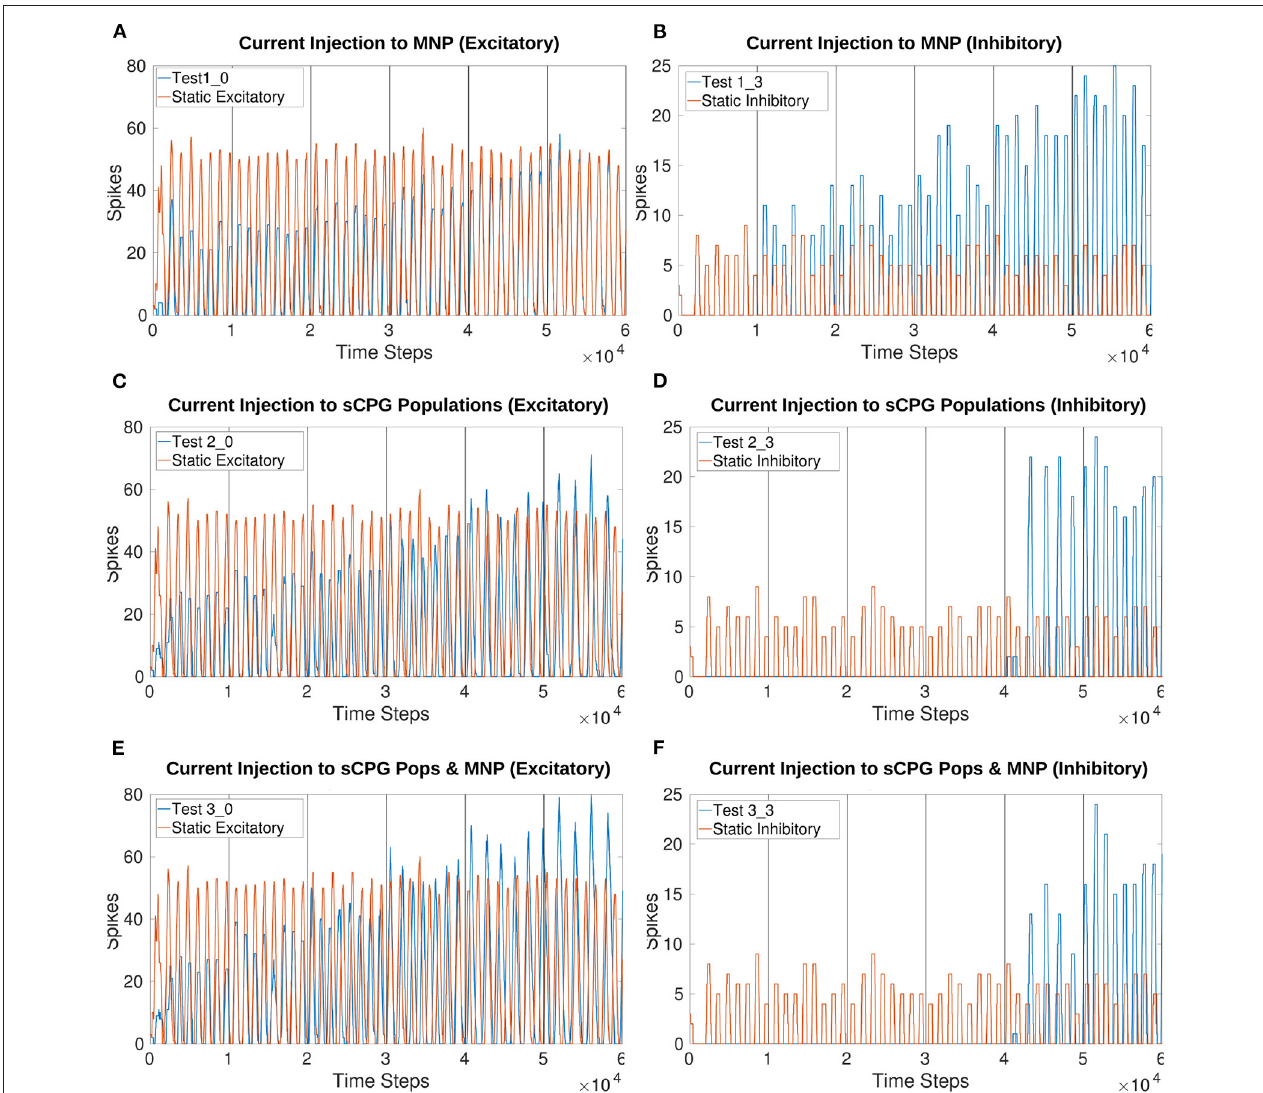
FIGURE 7 | Comparison of various current injection configurations to the original static input test. For the stepping tests 1, 2, and 3, I input to the NSI increases every 1,000 time steps (1s). Outputs show that current injection to the MNP changes the amplitude but the addition of current to the sCPG neurons creates a phase shift to the output. (A,B) Baseline stepping current tests injecting current from the NSI to the MNP; (C,D) I injection from the NSI to both sCPG populations; (E,F) I injection from the NSI to both sCPG populations and the MNP; Excitatory tests are on the left while inhibitory tests are on the right. See Tables 1 , 2 and Figures 4 , 5 for setup and details per test